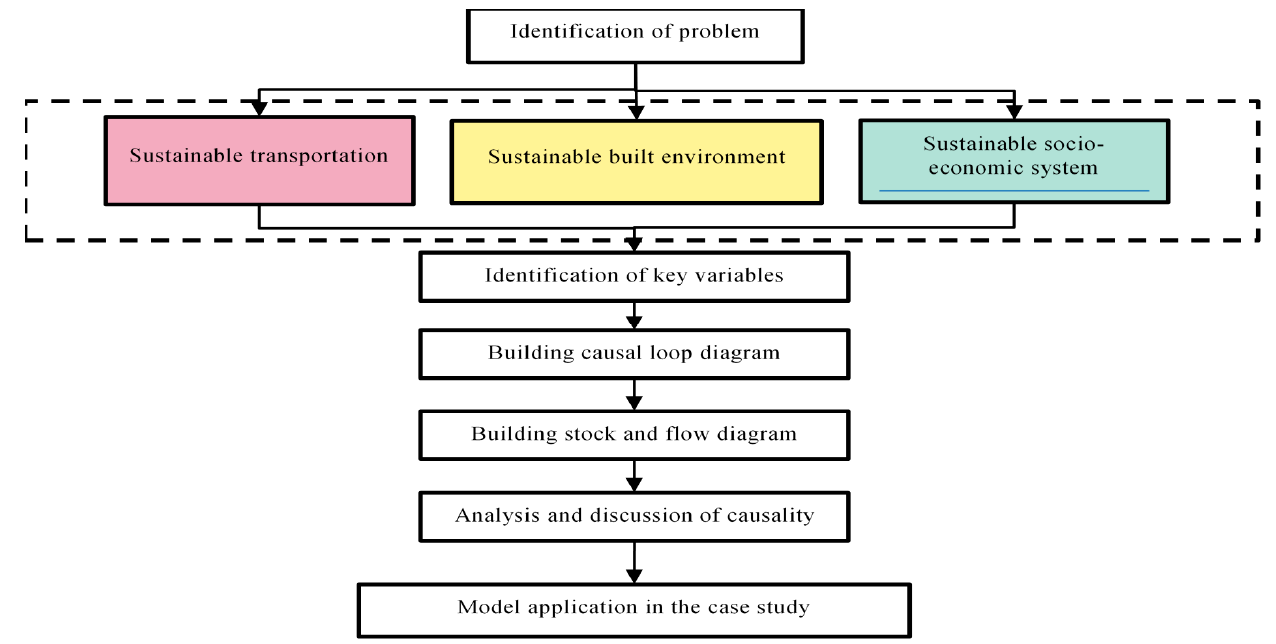
Figure 2. Methodology flowchart.